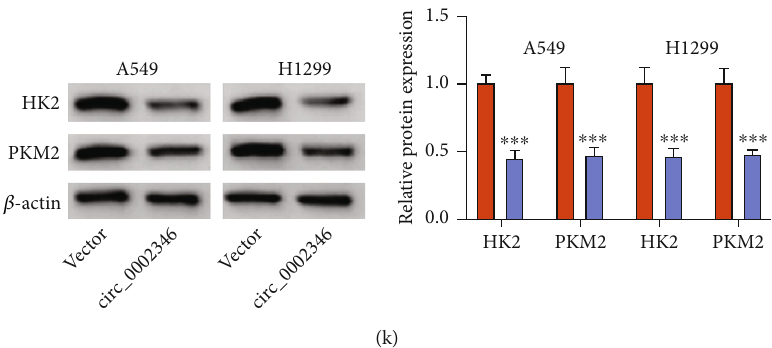
Figure 2: Overexpression of circ_0002346 suppresses the malignant behaviors of NSCLC cells. (a – k) NSCLC cells were transfected with vector or circ_0002346 plasmid. (a) The expression of circ_0002346 was determined by RT-qPCR. (b) An EDU assay was performed to assess the rate of DNA synthesis by measuring the incorporation of EDU. (c) A colony formation assay was conducted to measure the colony number to analyze cell proliferation ability. (d, e) Transwell assays were conducted to measure the numbers of migrated and invaded cells to analyze cell migration and invasion abilities. (f) Flow cytometry was conducted to analyze the cell apoptosis rate (the percentage of NSCLC cells with FITC + and PI +/- ). (g) The activity of caspase3 was analyzed using a caspase3 activity assay kit. (h) The expression of apoptosis-associated proteins (Bax and C-casp3) was measured in circ_0002346- overexpressed NSCLC cells by a Western blot assay. (i, j) The uptake of glucose and the production of lactate were determined using a fl uorescence-based glucose/lactate assay kit. (k) A Western blot assay was conducted to measure the protein expression of HK2 and PKM2 in circ_0002346-overexpressed NSCLC cells. ∗∗∗ P < 0 : 001